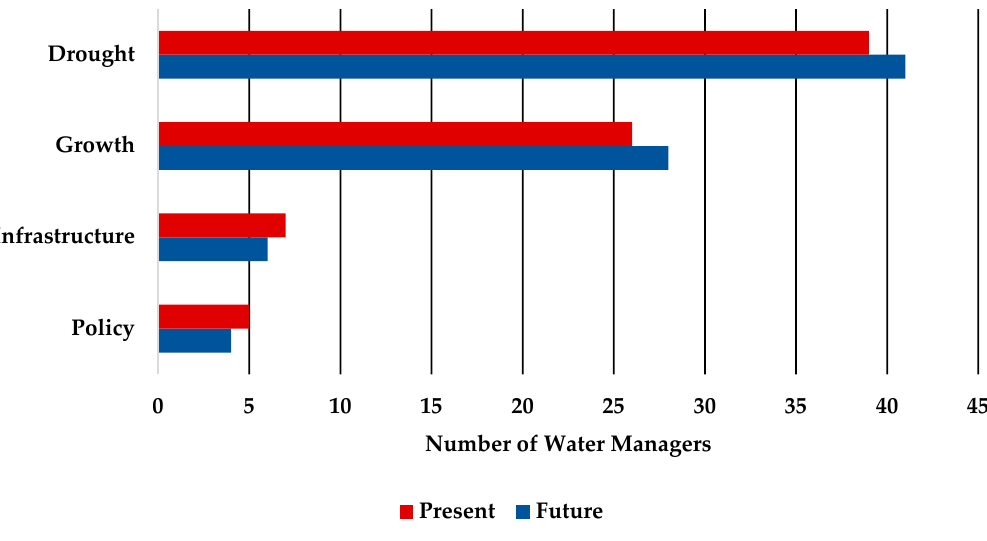
Figure 3. Present and future stressors on the Truckee-Carson River System. Water managers selected up to two stressors.